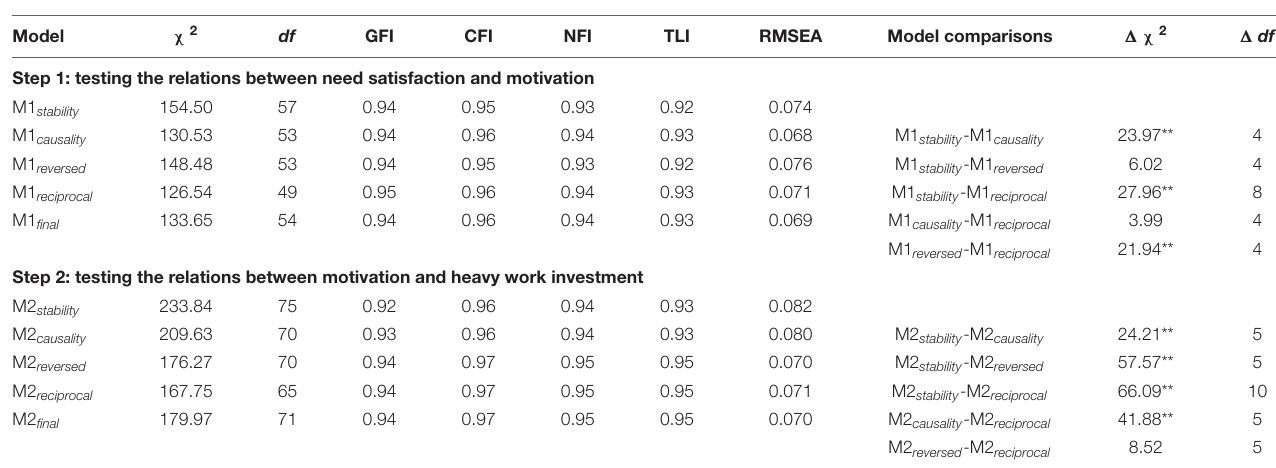
TABLE 3 | Fit indices for the models ( N =